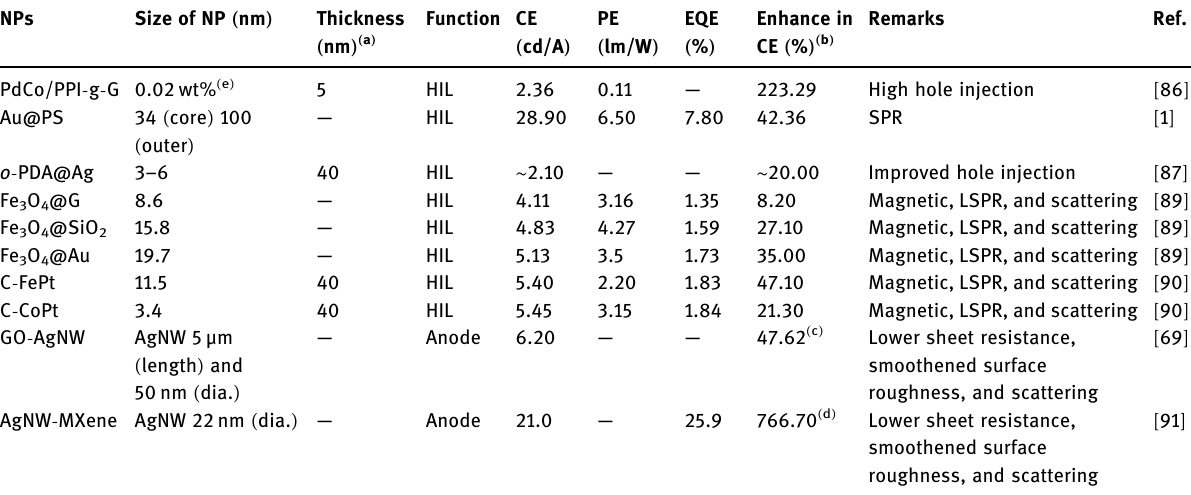
Table 4: Device characteristics of OLEDs with hybrid NPs - doped PEDOT:PSS